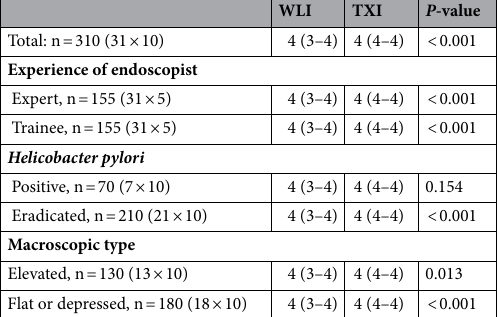
Table 3. Visibility scores of EGCs using WLI and TXI (subjective appearance of EGCs). Data on visibility scores are presented as the median and interquartile range. TXI Texture and color enhancement imaging, WLI White-light